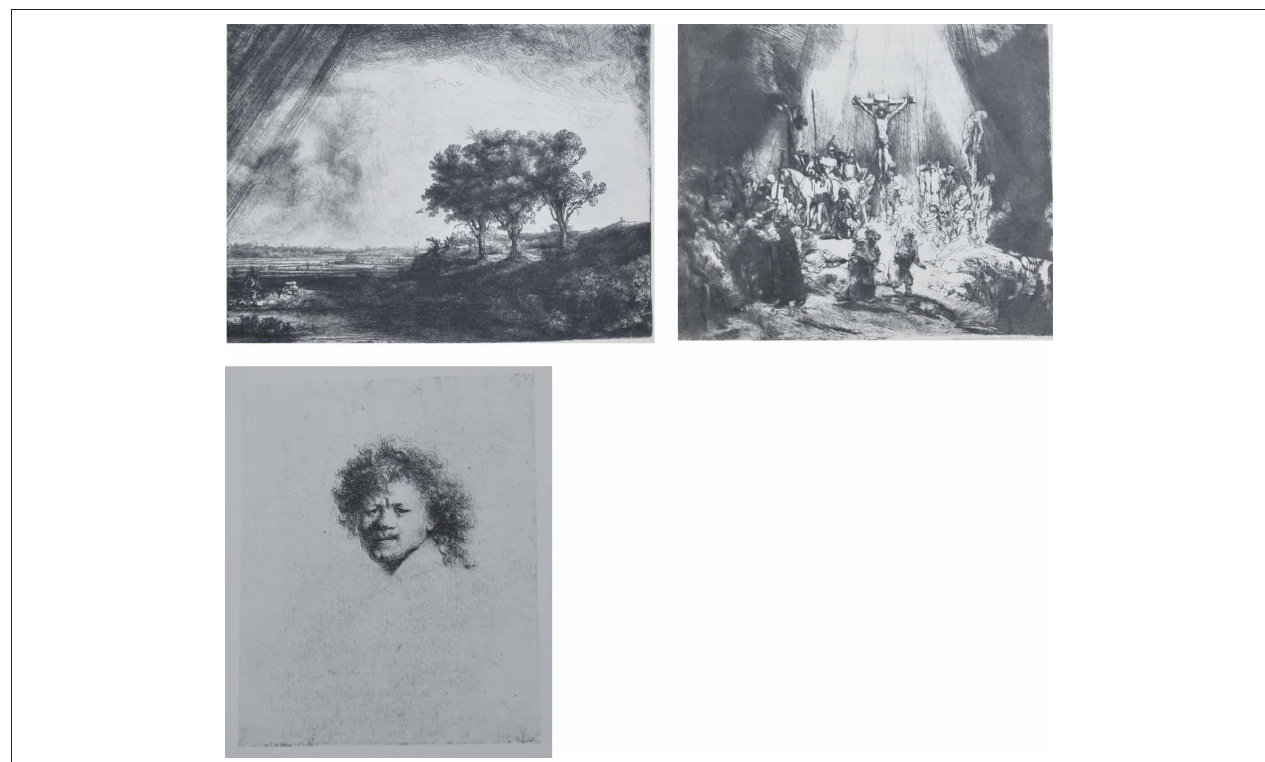
FIGURE 1 | Rembrandt VanRijn, (up left) Three trees, etching with dry point and engraving. (up right) The three cross, etching with dry point and engraving, (down left) Self portrait, etching with dry point and engraving.